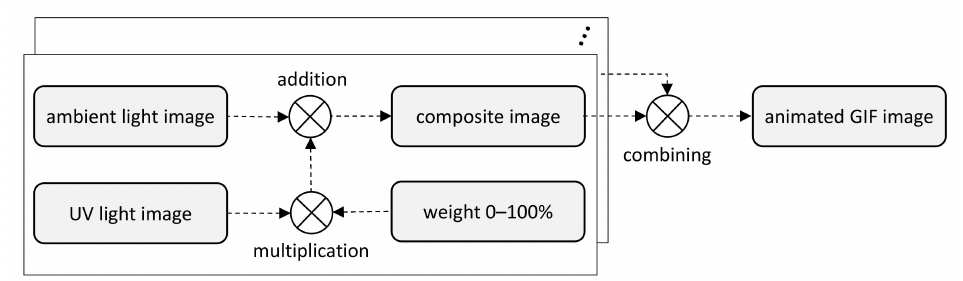
Figure 5. Setup of dynamic experiments using several composite images combined into GIFs.